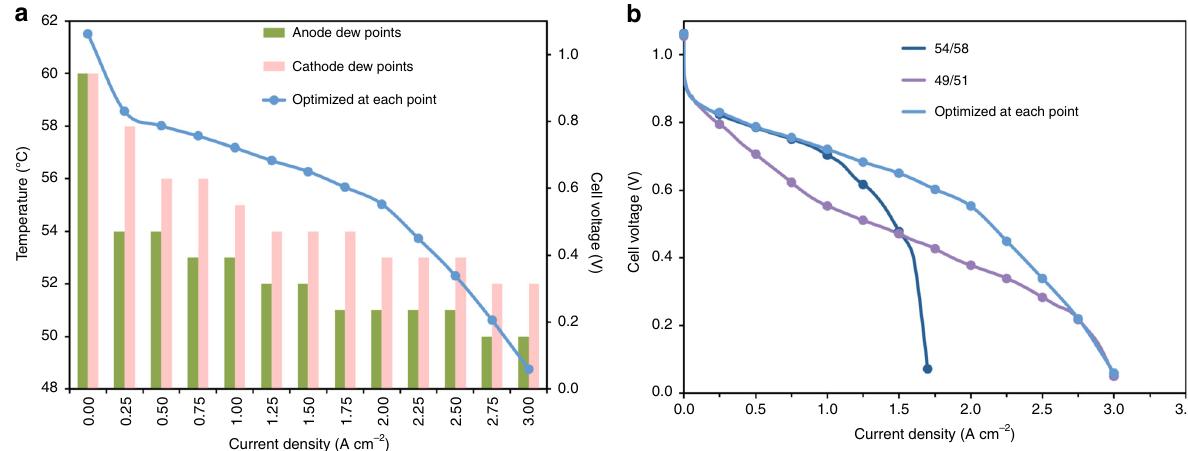
Fig. 3 Current-dependent dew point optimization. a Polarization curve of a PtRu/C anode, Pt/C cathode AMFC with dew points optimized at each current density with a step size of 250mAcm − 2 . Each condition was held for 30min, ( b ) Comparison of polarization curves optimized at each point (30mins/point) versus polarization curves where the dew points were set based on the optimum for a single current density, 3.0Acm − 2 (optimized dew points of 49°C/51°C) and 0.25Acm − 2 (optimized dew points of 54°C/58°C). The 49/51 curve was collected by stepping the current density backwards from 3 A cm − 2 in 0.25 A cm − 2 increments and the 54/58 curve was collected by stepping the current density forward from 0.25 A cm − 2 in 0.25 A cm − 2 increments. All conditions were held for 30 min. The anode and cathode loadings were 0.70mg PtRu cm − 2 and 0.60mg Pt cm − 2 , respectively. The cell operating temperature was 60